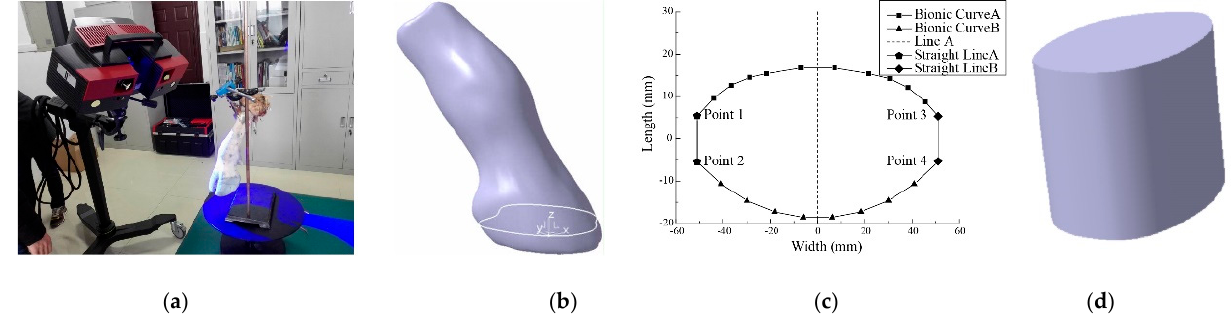
Figure 1. Design process of bionic structure. ( a ) data acquisition, ( b ) point cloud processing, ( c ) bionoc curve, ( d ) bionocal structure.